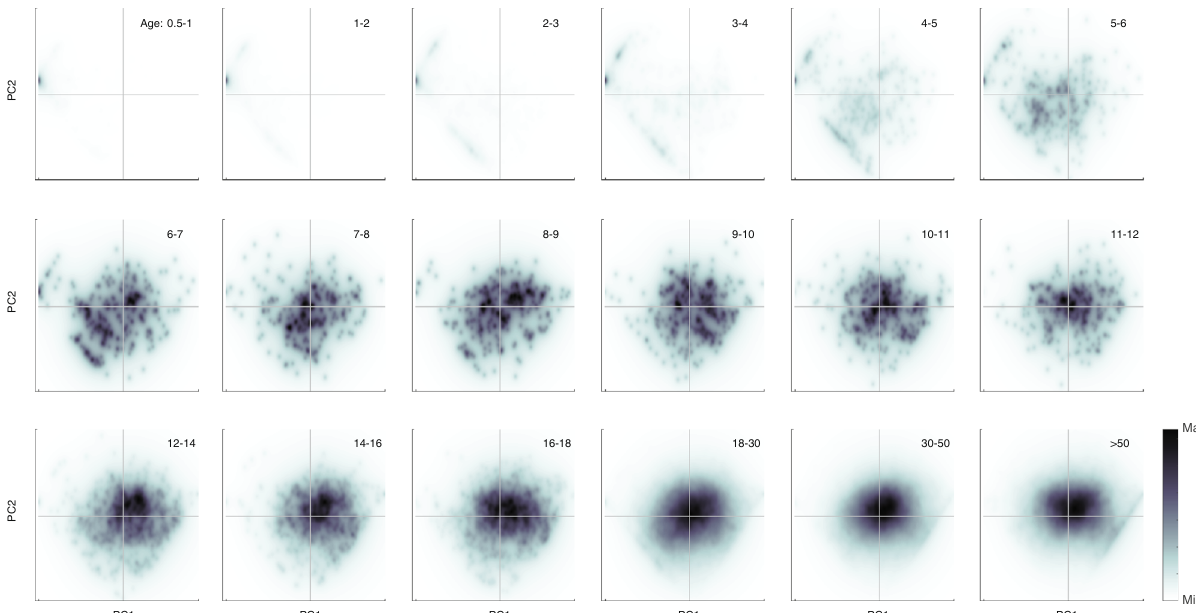
Fig. 3 Density plots of individuals in principal component space, broken down by age group (shown in upper right of each panel). Density is computed on a 256 × 256 grid spanning the minimum and maximum values of principal components one (PC1) and two (PC2). Color is scaled in each panel from zero ( “ Min, ” white) to the maximum number of individuals that appear in a pixel in that panel ( “ Max, ” black). Individuals move from the far left to the center and right of the PC1 – PC2 space during the fi rst 10 years of life, as a result of exposure to subtype H3N2 and H1N1 in fl uenza viruses. The lower-left and upper- left boundaries of the diamond shape in PC1 – PC2 space correspond to individuals who have only been exposed to one H1N1 strain (upper left) or those who have only been exposed to one H3N2 strain (lower left). Number of individuals (across all ages) shown here is n =